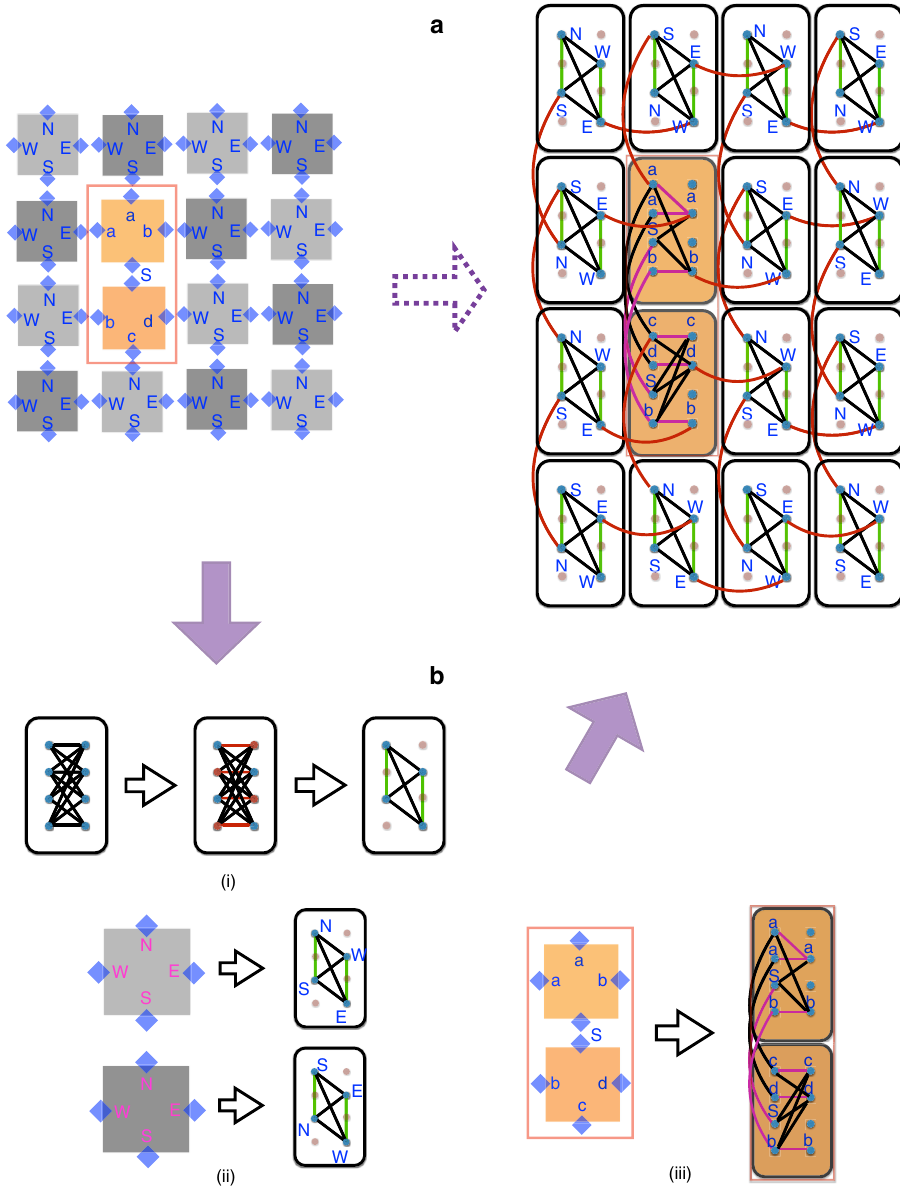
Figure 10 | Mapping onto the Chimera graph. Procedure for embedding a 4 (cid:4) 4 tile lattice into the Chimera graph. ( a ) Left: a generic tile lattice rotated by 45 (cid:2) . Spins are put on the boundary of each tile. The lattice can be further divided into two sublattices, depicted by dark and light grey respectively; right: embedding of the tile lattice into the Chimera graph. The ‘grout couplings’ are indicated by red links. ( b ) Embedding of each gate into the unit cells of the Chimera graph. (i) Left: a K 4,4 unit cell of the Chimera graph; middle: to couple qubits in the same column, we slave the qubits to their neighbours in the other column using additional ferromagnetic couplings indicated by red links; right: effectively we are left with four qubits that are fully connected. For simplicity, we hereafter denote the effective couplings between spins in the same column by a single green link. However, one should keep in mind that they are obtained by slaving the spins to the opposite column via large ferromagnetic couplings. (ii) The four qubits in the rotated square tile are labelled by their locations on the tile: N (North), S (South), W (West) and E (East). Tiles corresponding to different sublattices must be embedded differently due to the special connectivity of the Chimera graph. (iii) Embedding of the TOFFOLI gate consisting of two square tiles into two unit cells. (a,b,c,d) corresponds to the input and output bits of the gate, and S is the ancilla bit. In the unit cell, ferromagnetic couplings that copy spins are indicated by purple links, and couplings required in Hamiltonian (7) are indicated by black the number of steps) of the computation is a polynomial in N , this column–column where h i , j i labels pairs of ‘twin’ spins i and j on the boundary between two adjacent computation reaches the output boundary, and thus solves the problem, in poly- tiles and the sum ranges over all such pairs of the system. nomial time. Boundary conditions . Completing the description of the 2D model of universal As mentioned earlier, by using reversible gates one can also represent computational problems with mixed input–output boundary conditions for which classical computation requires a discussion of boundary conditions, which deter- only a fraction of the bits on the left (input) edge and a fraction of the bits on the mine the type of computational problem one is addressing. For example, if the right (output) edge are fixed. A concrete example is the integer factorization N -bit input is fully specified and one is interested in the output, all that is needed is problem implemented in terms of a reversible integer multiplication circuit. A to transfer the information encoded into the input left to right by applying reversible circuit for multiplying two N -bit numbers p and q can be constructed sequentially the gates one column of tiles at a time. In this case, if the depth (that is,